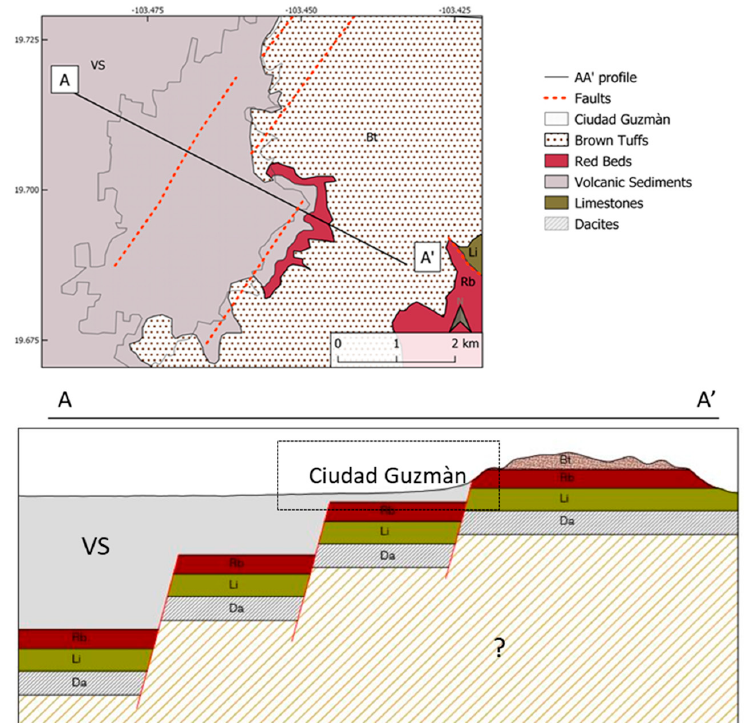
Figure 2. Simplified Geological map of Ciudad Guzman. (VS) Volcanic Sediments; (BT) Brown Tuffs—Plio-Quaternary deposits; (Rb) Red beds—Late Cretaceous; (Li) Limestone; (Da) Dacites—Early Cretaceous. On the bottom, the schematic geological cross-section relative to the AA’ profile in Figure 2a (modified from [19]).